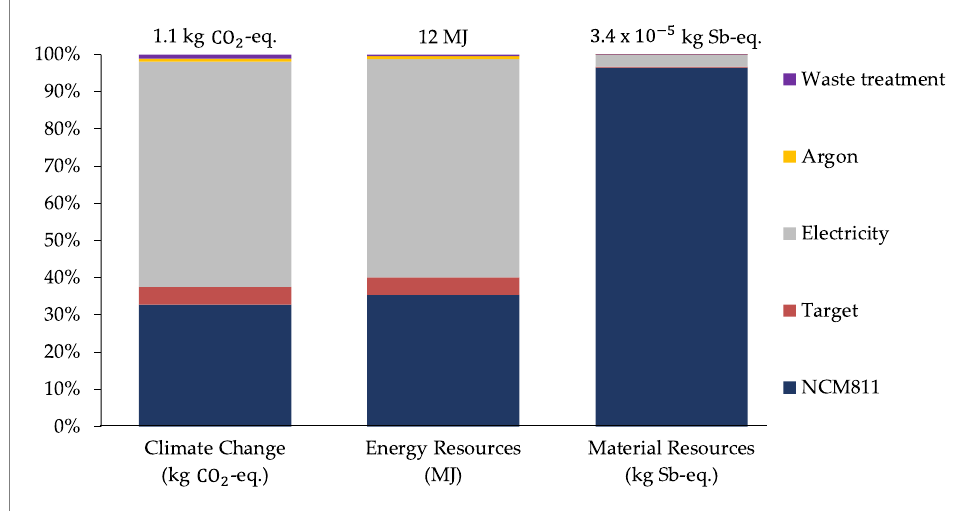
Figure 7. LCIA Results for the PVD/MS Process with a Reference Flow of 15 g of Input NCM811.